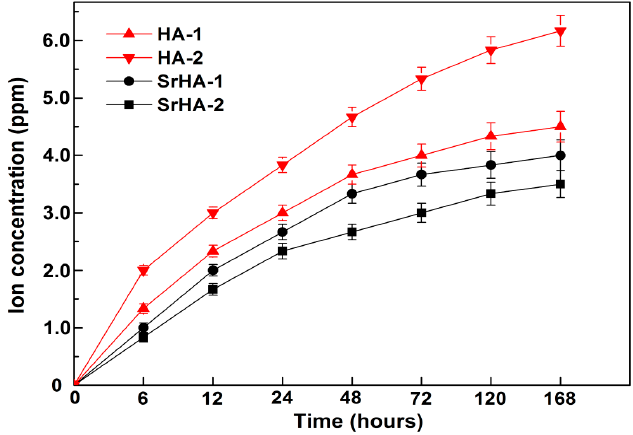
Figure 7. Cumulative Ca 2+ (red line) and Sr 2+ (black line) ion release as a function of time.